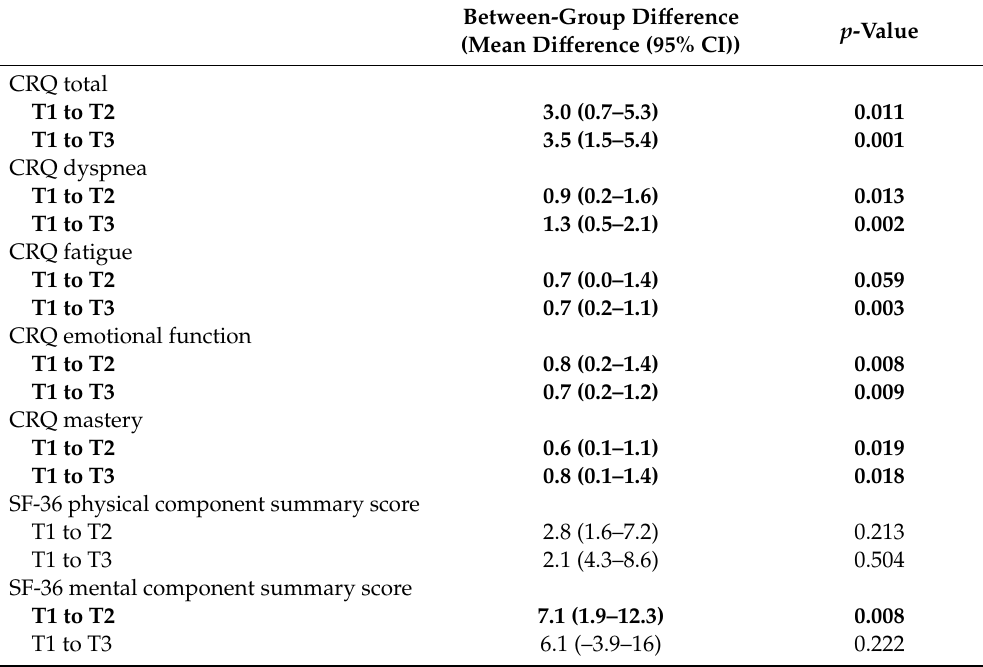
Table 2. Di ff erences between UC and PR groups in quality of